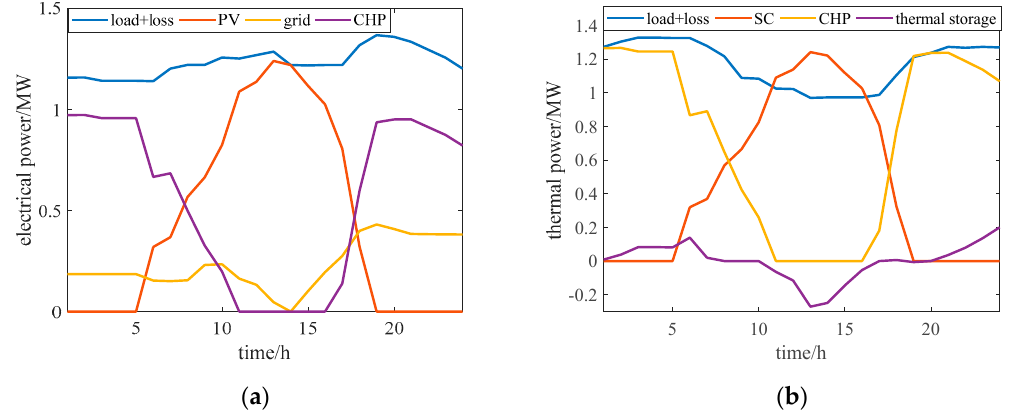
Figure 9. ( a ) Electrical power output in Case 2.4; ( b ) thermal power output in Case 2.4.